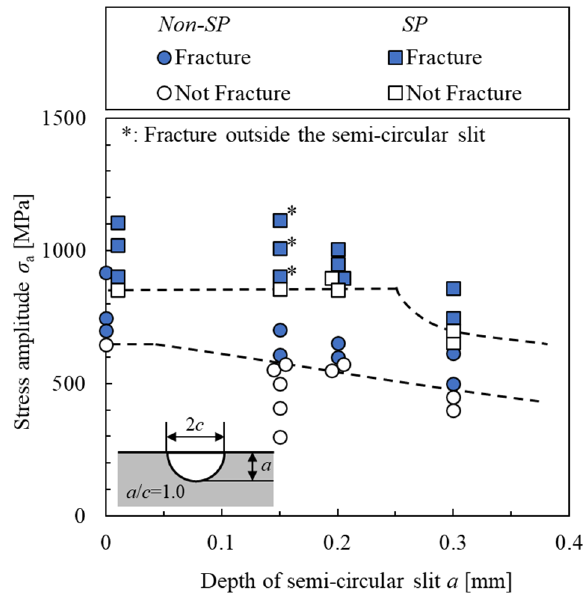
Figure 10. Relationship between stress amplitude and slit depth.